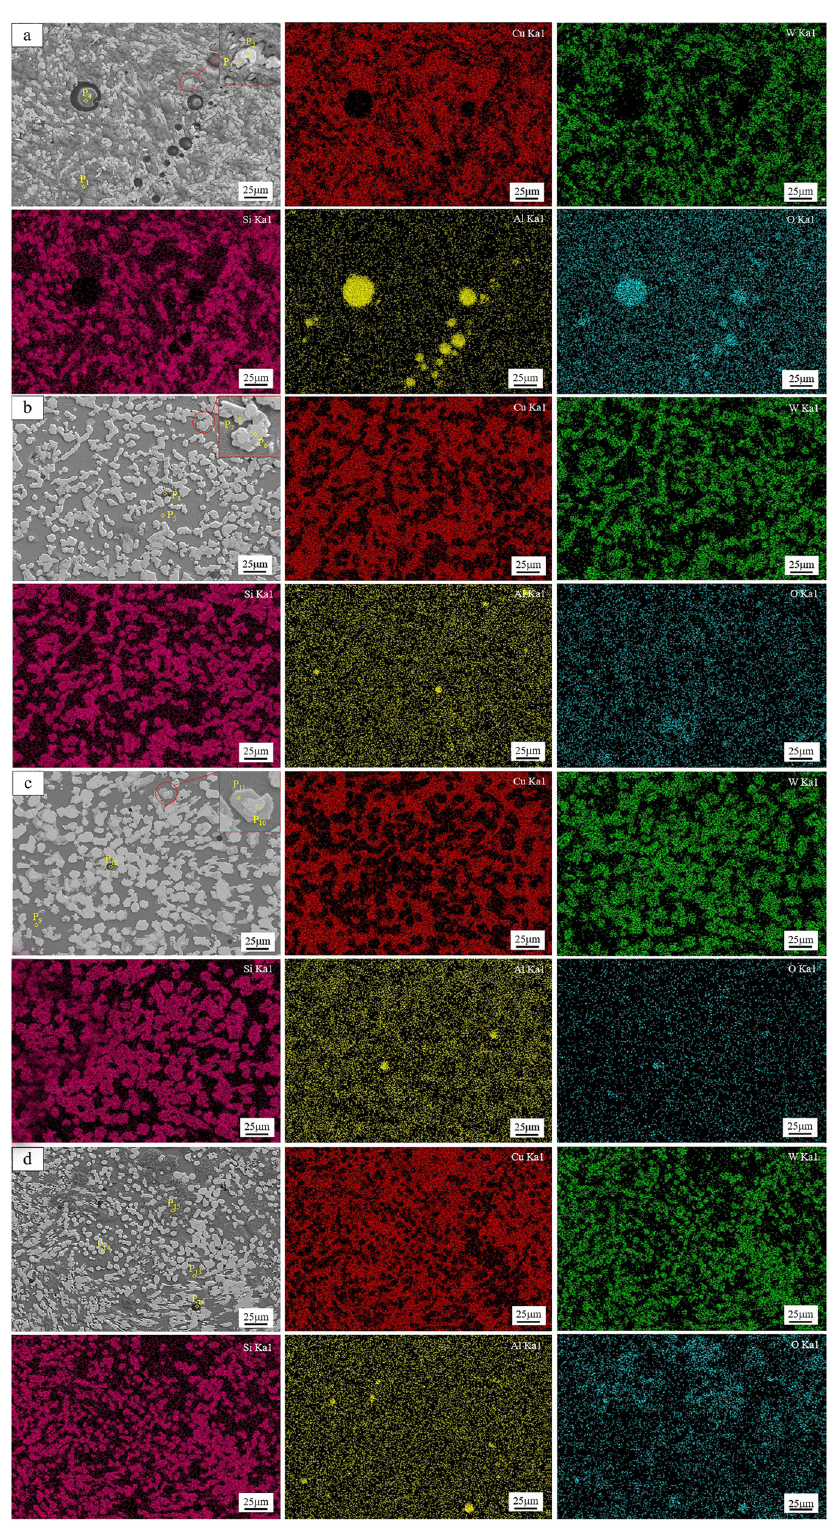
Figure 3: SEM images ( 1,000 ×) and element distribution of the CuW composites prepared with di ff erent R ( C/A ) ( a: 0, b: 0.2, c: 0.6, and d: 1.0 )